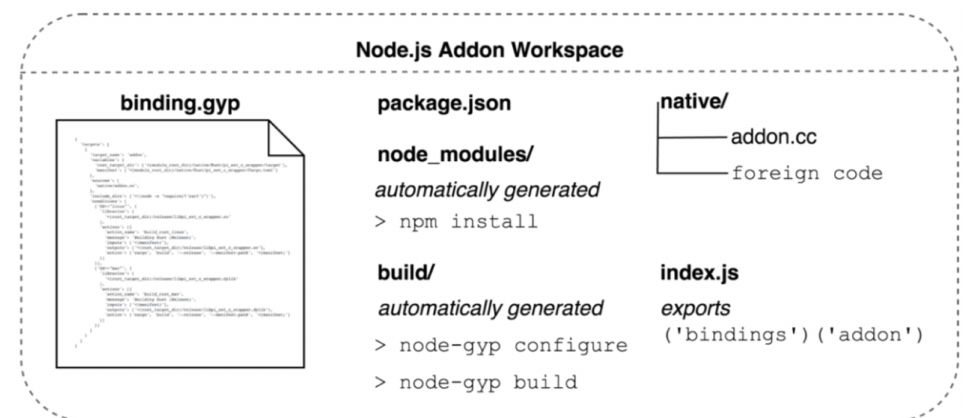
Figure 3. Node.js addon